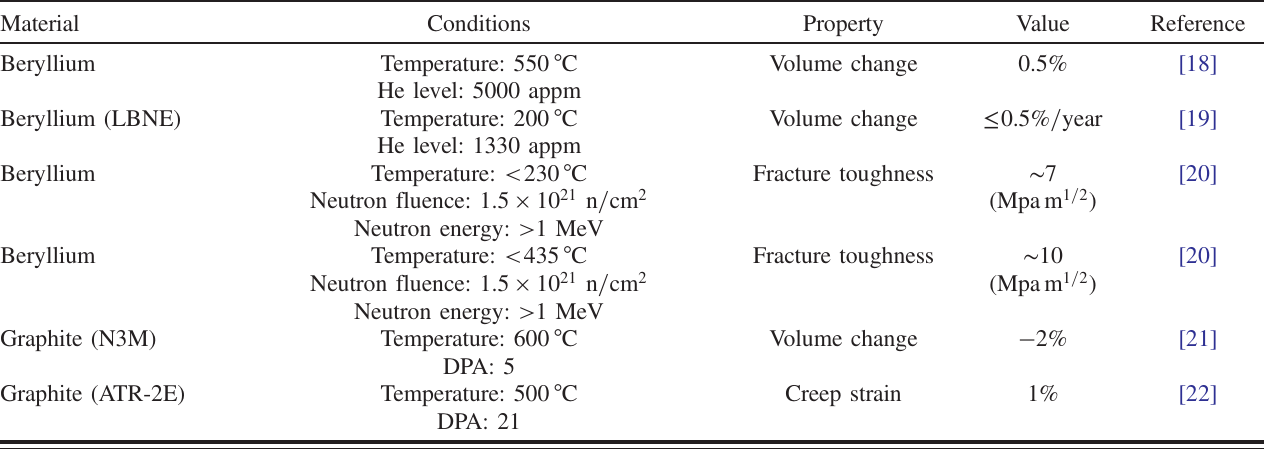
TABLE III. Experimental reference values of radiation damage effects in beryllium and graphite.